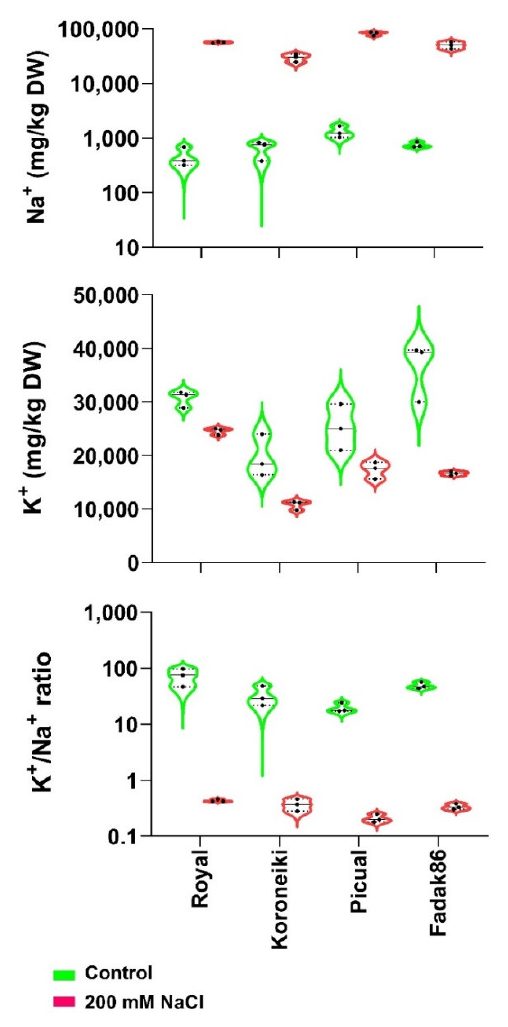
Figure 3. The violin graphs for Na + and K + ions and their ratio in leaves of analyzed plants. Each plot shows the distribution of data for four cultivars from the minimum to the maximum level, with horizontal inner lines showing the median. Dot lines represent the lower and upper limits of the first and third quartiles. The horizontal width of the violin depends on data density.